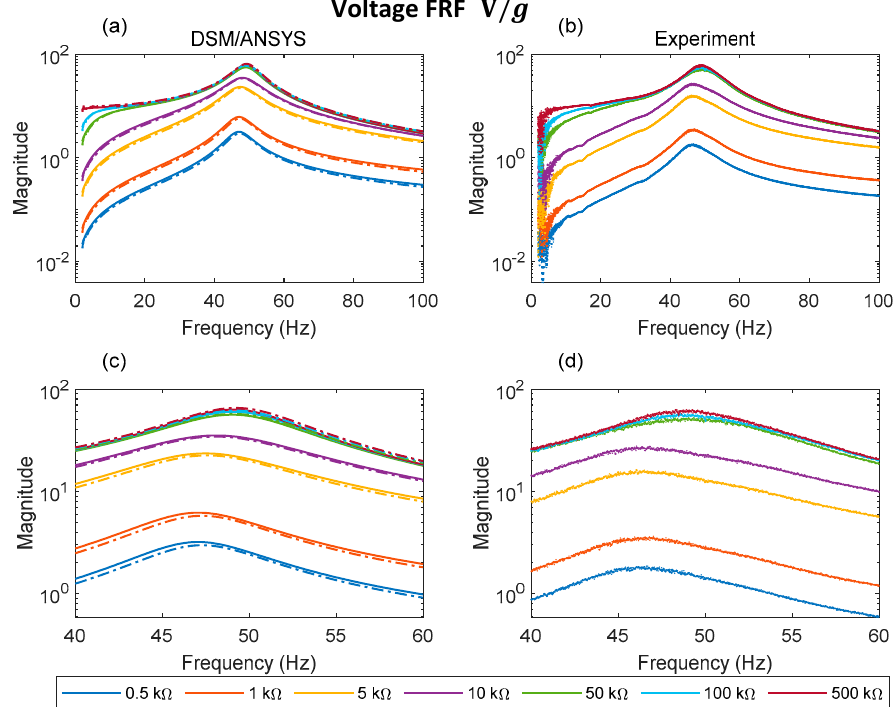
Figure 10. Analytical and experimental voltage FRF for different electrical loads: ( a ) DSM/ANSYS; ( b ) experiment; ( c ) DSM/ANSYS result zoomed in resonance region; ( d ) experimental result zoomed in resonance region (dashed and solid lines in ( a , c ) represent data associated with ANSYS plane element model and DSM, respectively).